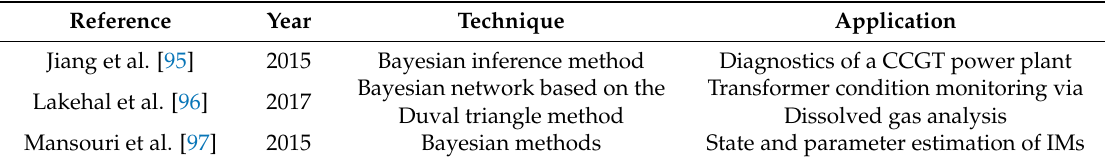
Table 10. Application of Bayesian methods in the field of electrical machines and power systems.